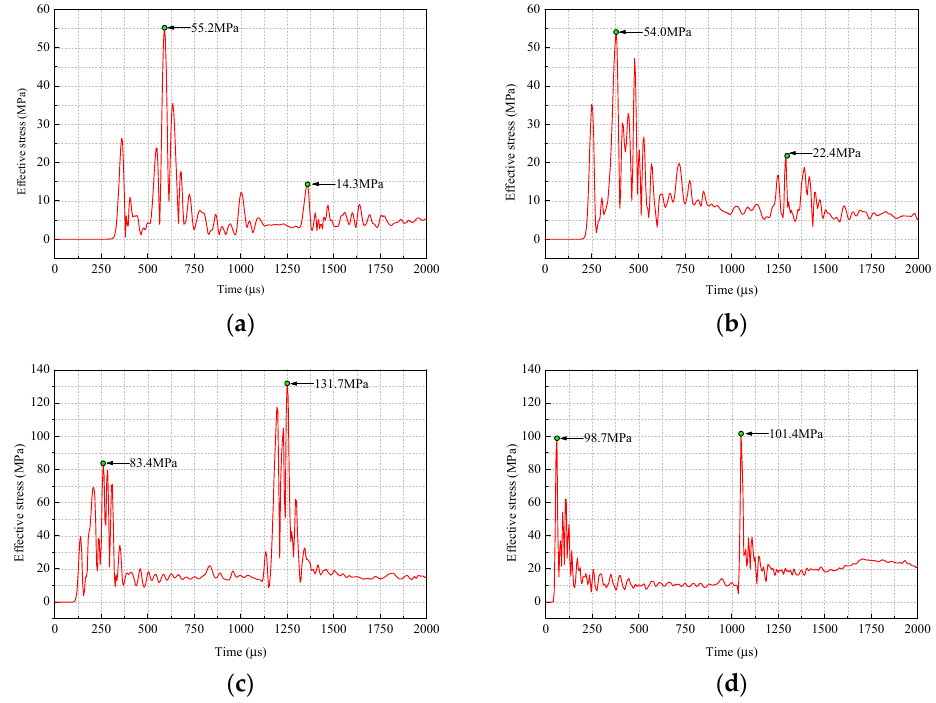
Figure 8. Stress − time curves of typical stress monitoring points: ( a ) 0.7 m, ( b ) 1.3 m, ( c ) 1.9 m, and ( d ) 2.5 m.